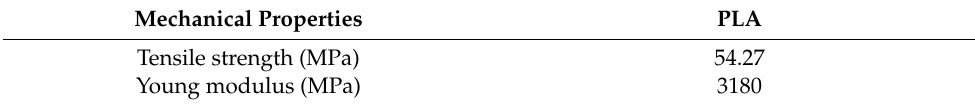
Table 2. Mechanical properties of PLA, data from [24]. Mechanical